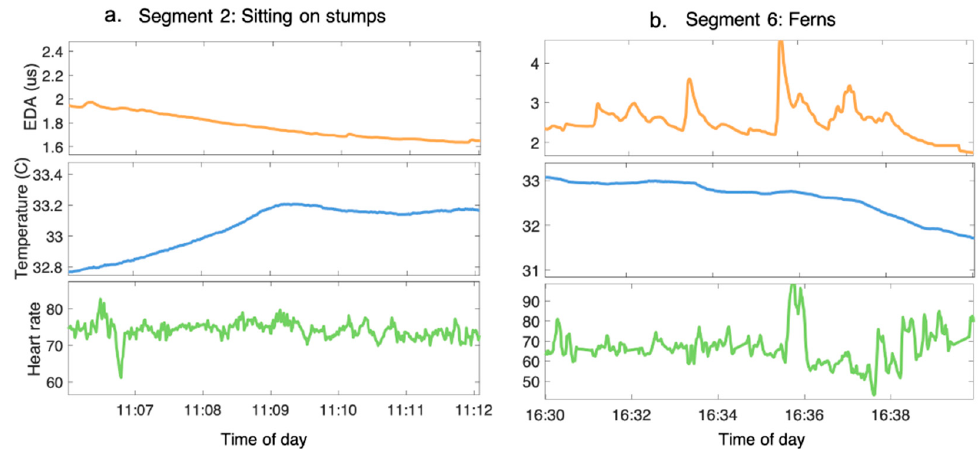
Figure 1. Examples of pre-processed EDA, skin temperature, and HR signals during activity segments in the forest. ( a ). The participant’s signals during segment 2 when they were sitting in a circle on tree stumps, listening to the guide talk. ( b ). The participant’s signals during segment 6, when they were sitting in a bed of ferns. During segment 6, participants were asked to focus on various sensory stimuli, such as sound and the patterns on the leaves.